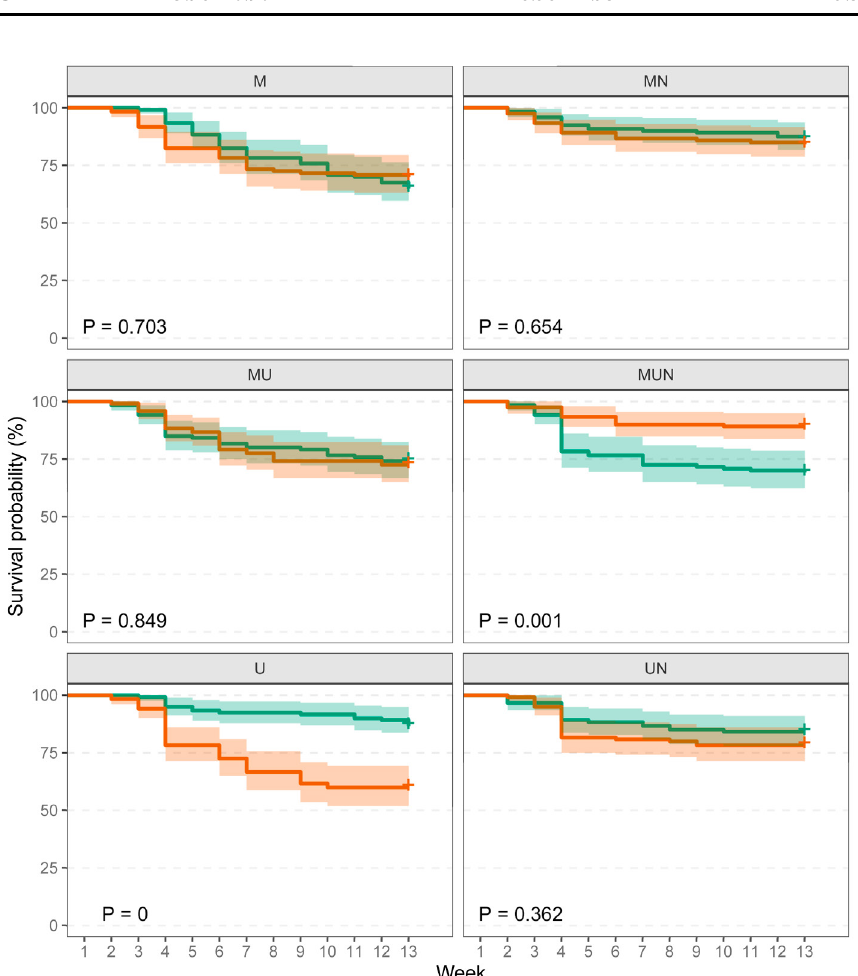
Fig. 2. – Kaplan-Meier cumulative survival curves for pure red abalone (RR, red line) and hybrid abalone (RG, green line) during the 13- week feeding trials. Solid and shaded lines represent the mean survival probability and the 95% confidence intervals. For each diet, significant differences between RR and RG crosses are indicated (chi square test). M, Macrocystis pyrifera ; U, Ulva ohnoi ; MU, M. pyrifera and U. ohnoi ; MN, M. pyrifera and N. incerta ; UN, U. ohnoi and N. incerta ; MUN, M. pyrifera , U. ohnoi and N.